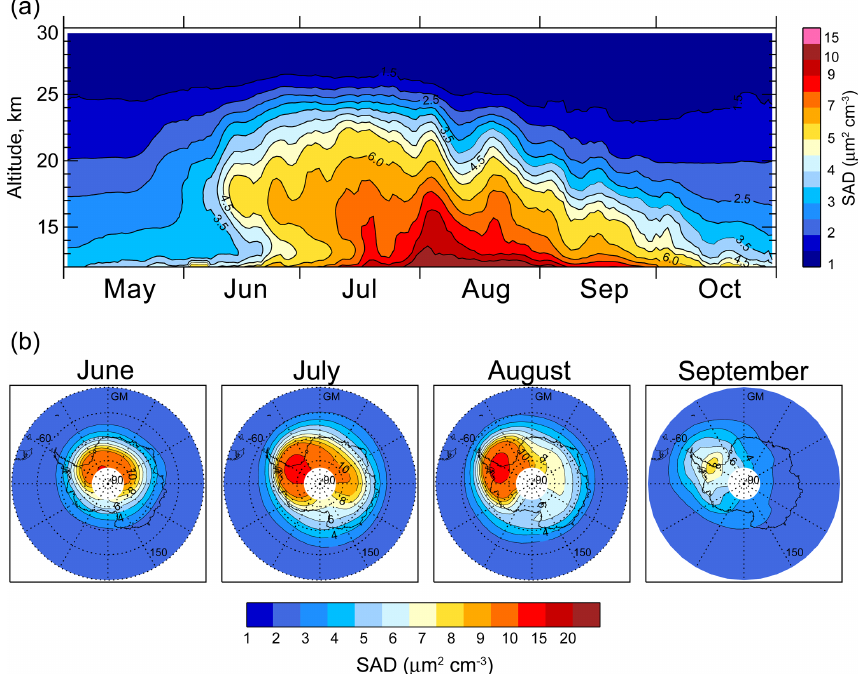
Figure 26. (a) Twelve-year mean seasonal evolution of Antarctic vortex-averaged SAD. (b) Twelve-year average, monthly mean polar maps of SAD over the Antarctic at 18km for